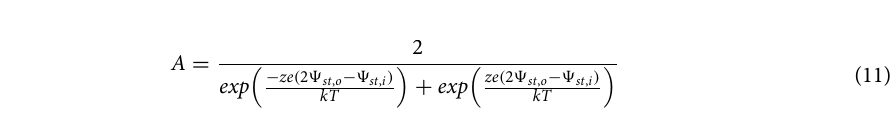
Figure 3. A schematic showing the variation in the concentration of permeable anions and cations across the bulk medium, double-layers and